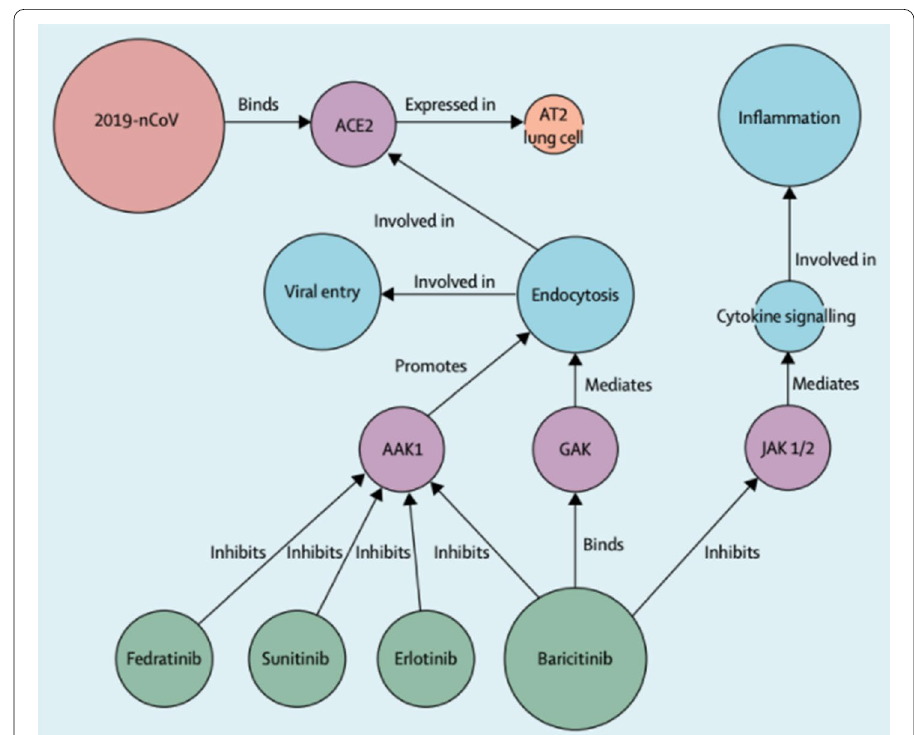
Fig. 7 BenevolentAI Knowledge Graph used to suggest baricitinib as a treatment for COVID-19 (Image taken from Richardson et al.